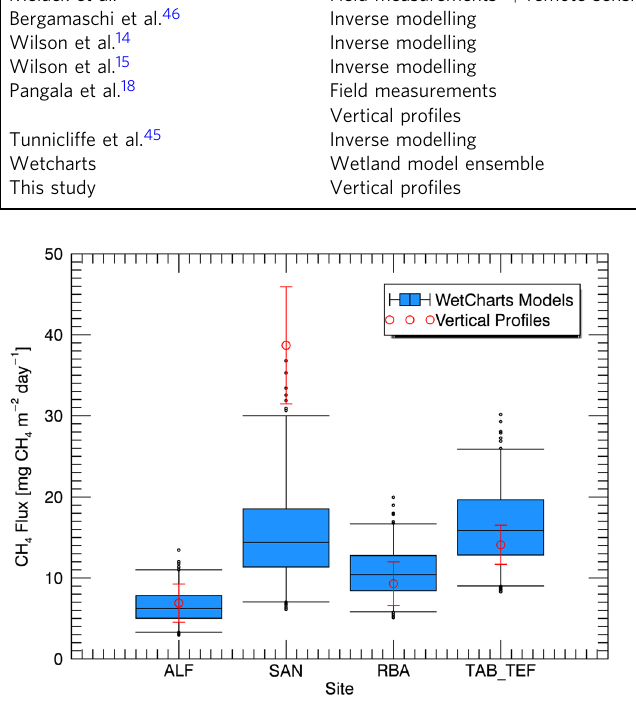
Fig. 5 Wetland fl uxes upwind of each site. Boxes show the 25th, median, and 75th percentile of fl uxes upwind of each site from the WetCharts model ensemble (see “ Methods ” ); whiskers bound the inner 95% of the distribution and small circles show outliers beyond those limits. Red circles and error bars show the 2010 – 2018 mean and uncertainty for wetland fl uxes upwind of each site based on vertical pro fi le data, after some adjustments (Table